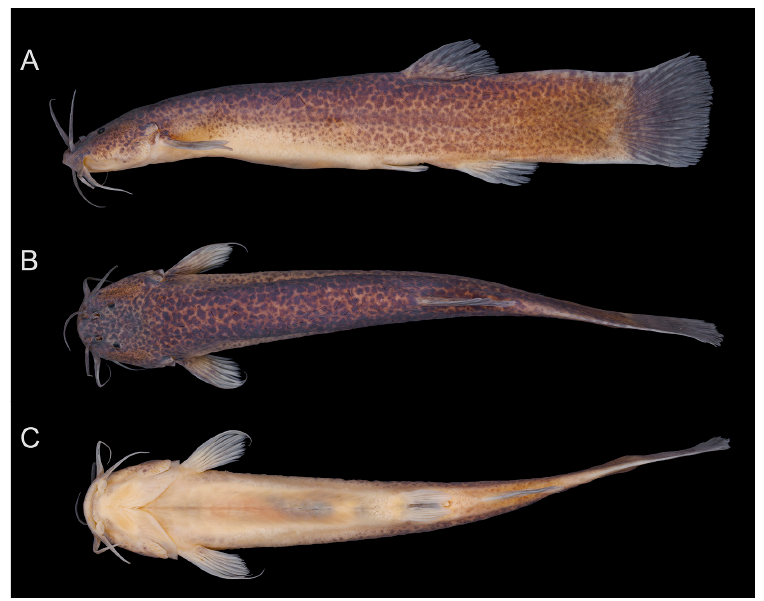
Figure 4. Trichomycterus ( Cryptocambeva ) garbei Costa, Azevedo-Santos & Katz sp. nov. Holotype, UFRJ 12824, Cristais Paulista Municipality, 60.8 mm SL: ( A ) lateral, ( B ) dorsal, and ( C ) ventral views. Holotype. UFRJ 12917, 60.8 mm SL; Brazil: São Paulo State: Cristais Paulista Municipality: stream tributary of Rio Canoas, which is a tributary of Rio Grande at Estreito dam, road Cristais Paulista to Mascarenhas, 20°18 ′ 07 ′′ S 47°18 ′ 45 ′′ W, at about 715 m asl; V. M. Azevedo-Santos et al., 16 April 2022. Paratypes. UFRJ 12918, 11 ex., 32.3–70.5 mm SL; UFRJ 12960, 3 ex., 38.8–53.3 mm SL (C&S); CICCAA 07645, 4 ex., 42.6–49.6 mm SL; UFRJ 12896, 9 ex. (DNA), 34.3–62.5 mm SL; collected with holotype.